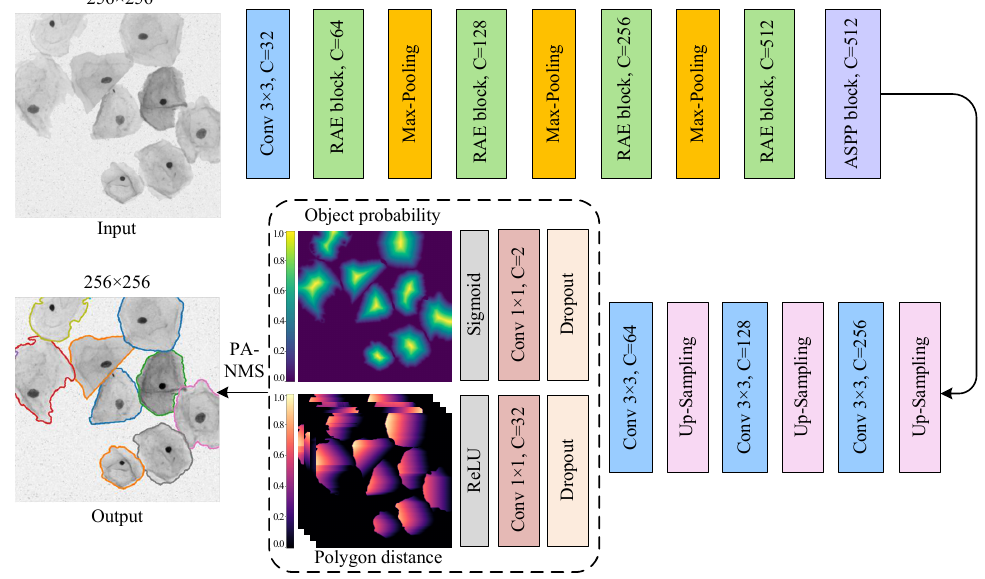
Figure 4. The overall structure of SPCNet, which adopts an encoder-decoder structure and mainly consists of down-sampling and up-sampling paths. Here, the rectangular bars of different colors represent different functional modules, and C denotes the number of channels in the feature map. In the output image, the cell outlines of different colors indicate the segmented cervical cell